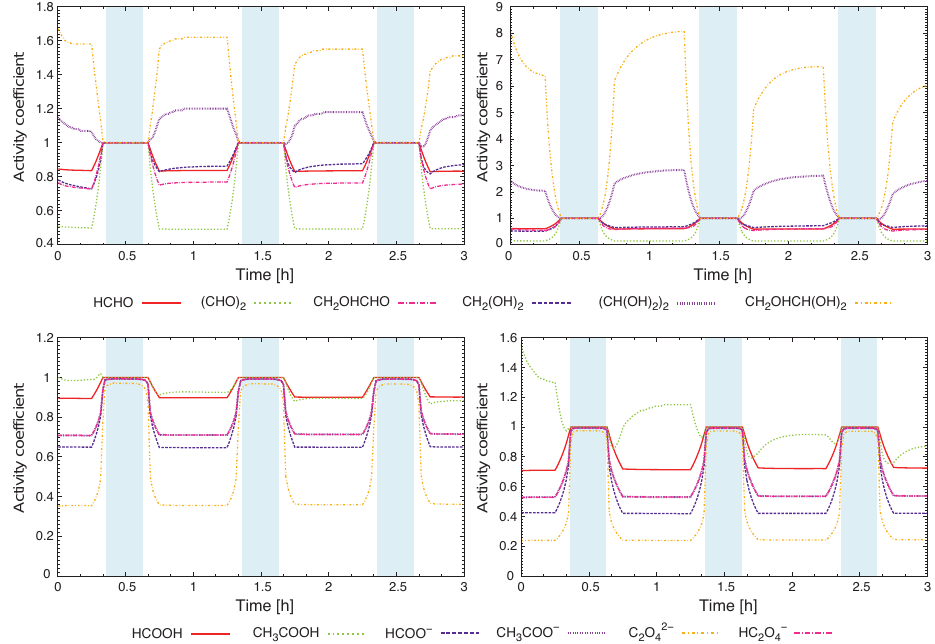
Figure 13. Modeled activity coefficients of organic carbonyl compounds (top) and organic acids/anions (TMIs, down) as the function of the simulation time for the two different relative humidity cases (left: 90%RH, right: 70%RH). The blue bars mark the in-cloud time periods during the simulation